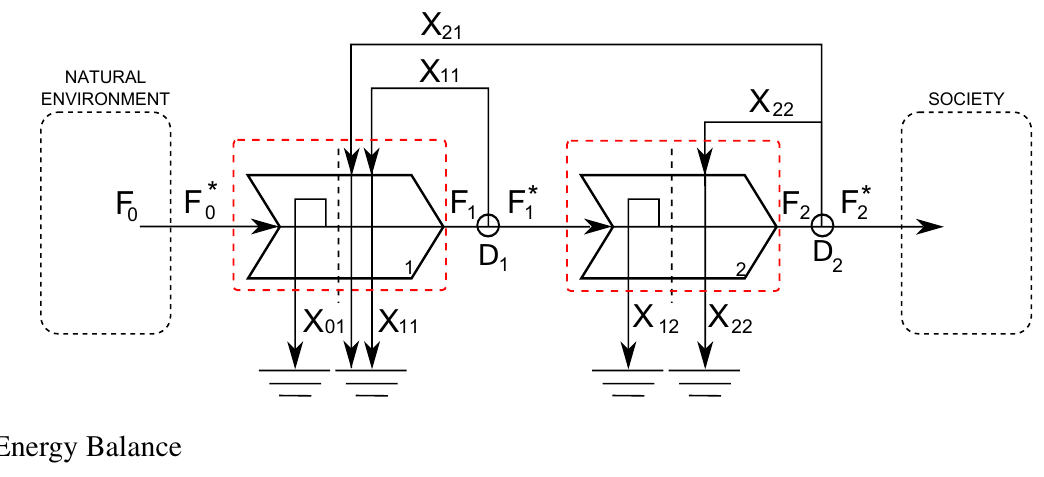
Figure 9. Energy production process with one pathway and two